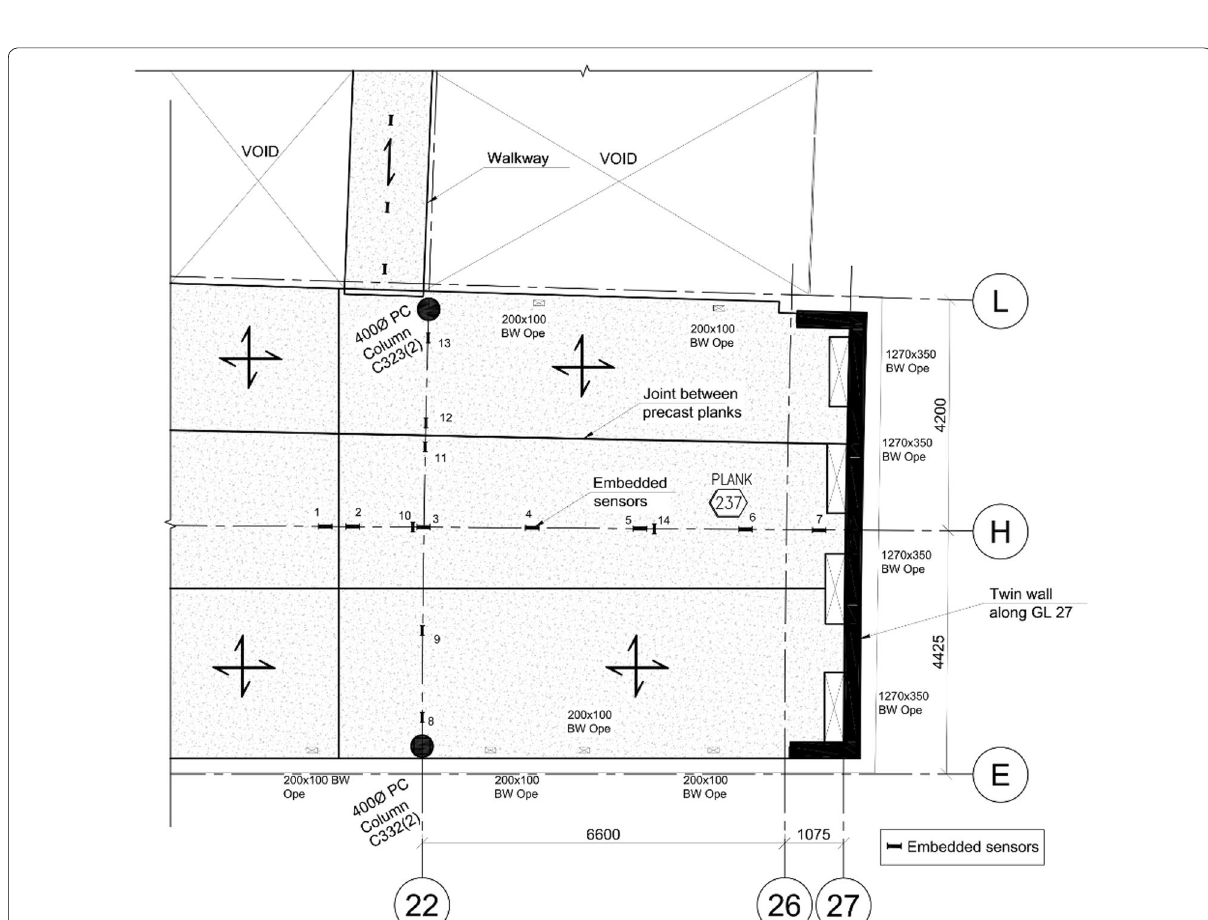
Fig. 5 Embedded sensors in one zone of the second floor of HBB (Newell and Goggins